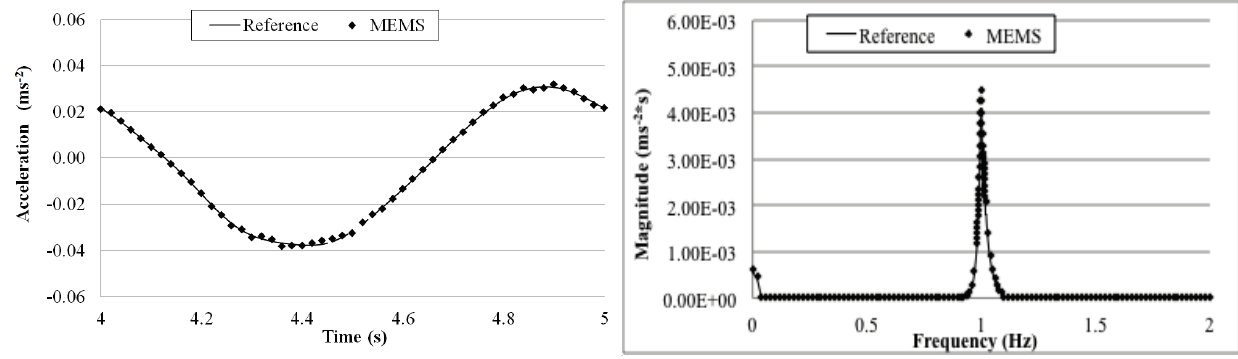
Figure 17. Comparison of measurements by the two sensors in time and frequency domains (1 Hz sinusoidal excitation).